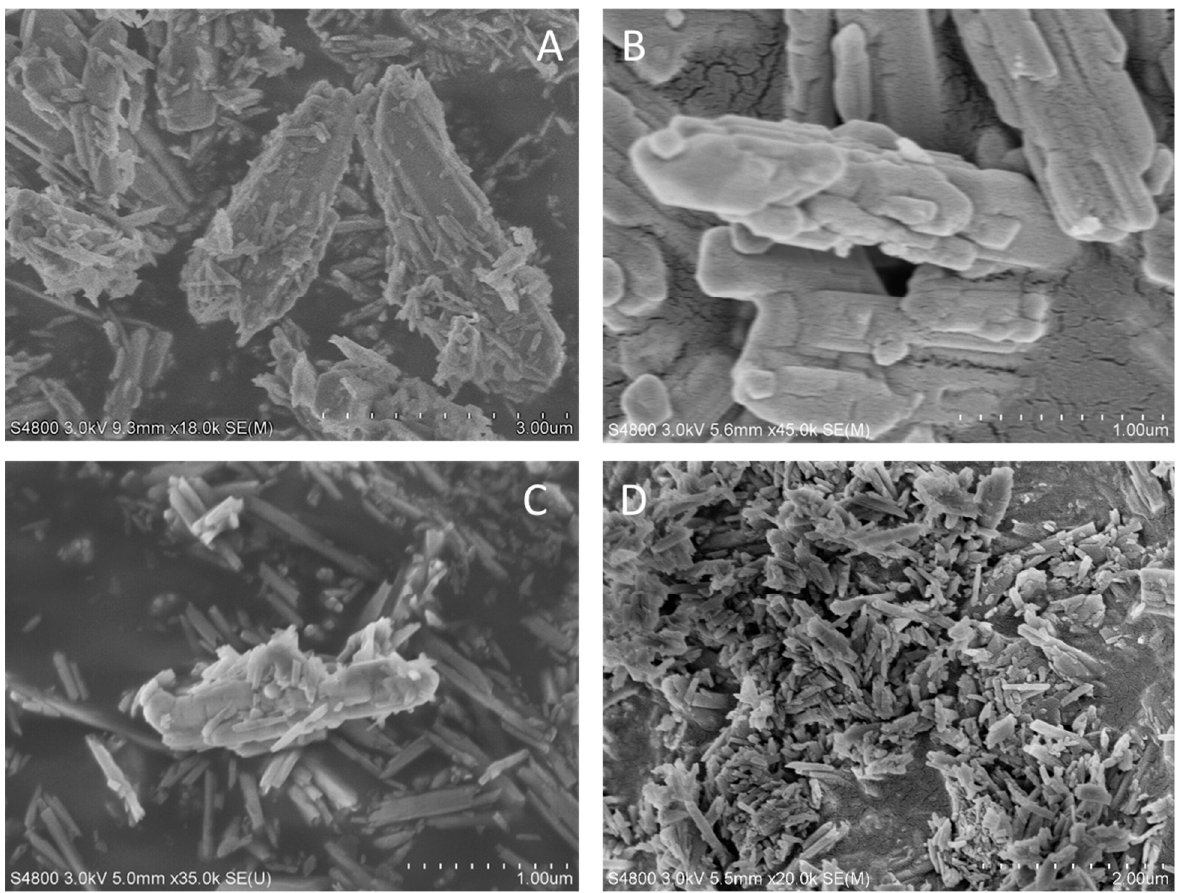
Figure 3. SEM images of SrHNTs of multiple attempts ( A – D ) show sediment-like formation on the surface of HNT.